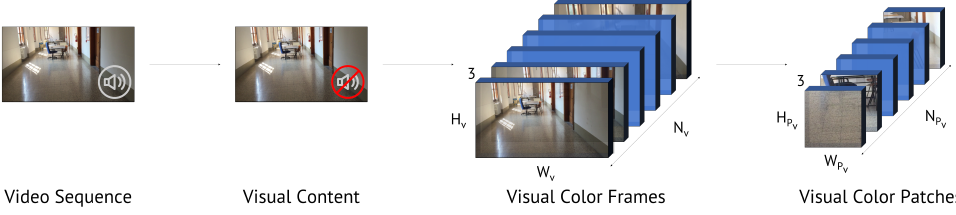
Figure 3. Extraction of visual patches from a video sequence. We extract N v color frames, with size H v and W v . From these frames, we randomly extract N P